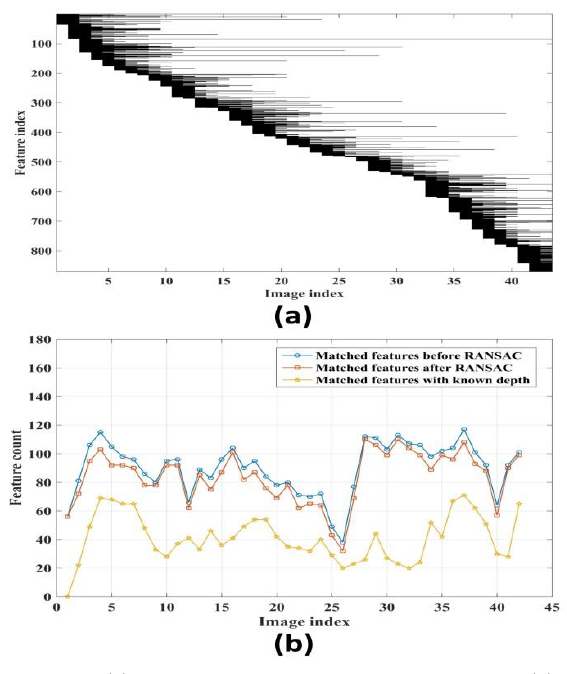
Figure 8. (a) Visibility of extracted features in images (b) Number of matched features before RANSAC after RANSAC and those matched with features whose depth is known.